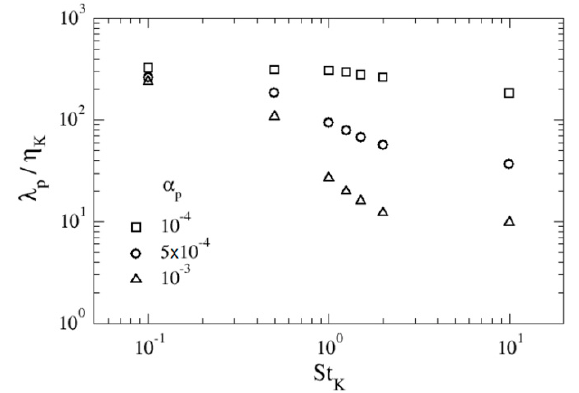
Figure 7. Mean free path over Kolmogorov length scale as a function of particle Stokes number for the three evaluated average volume fractions.